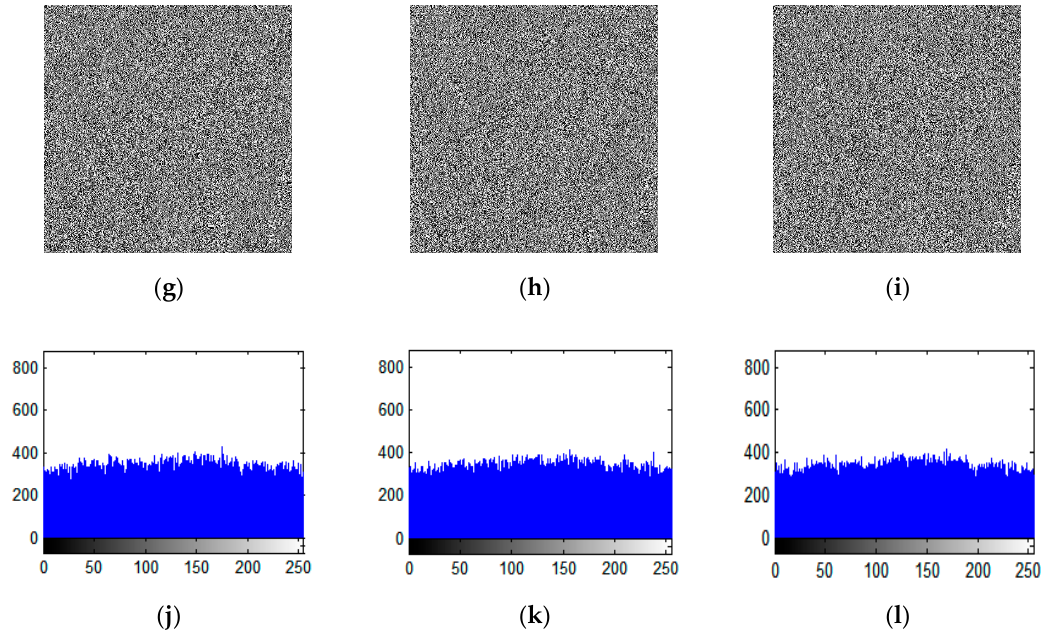
Figure 11. The histogram comparison tests before and after encryption: ( a ) The original Lena image; ( b ) The original Cake image; ( c ) The original Waterfront image; ( d ) The histogram of the Lena image; ( e ) The histogram of the Cake image; ( f ) The histogram of the Waterfront image; ( g ) The encrypted Lena image; ( h ) The encrypted Cake image; ( i ) The encrypted Waterfront image; ( j ) The histogram of the Lena image after encryption; ( k ) The histogram of the Cake image after encryption; ( l ) The histogram of the Waterfront image after encryption.